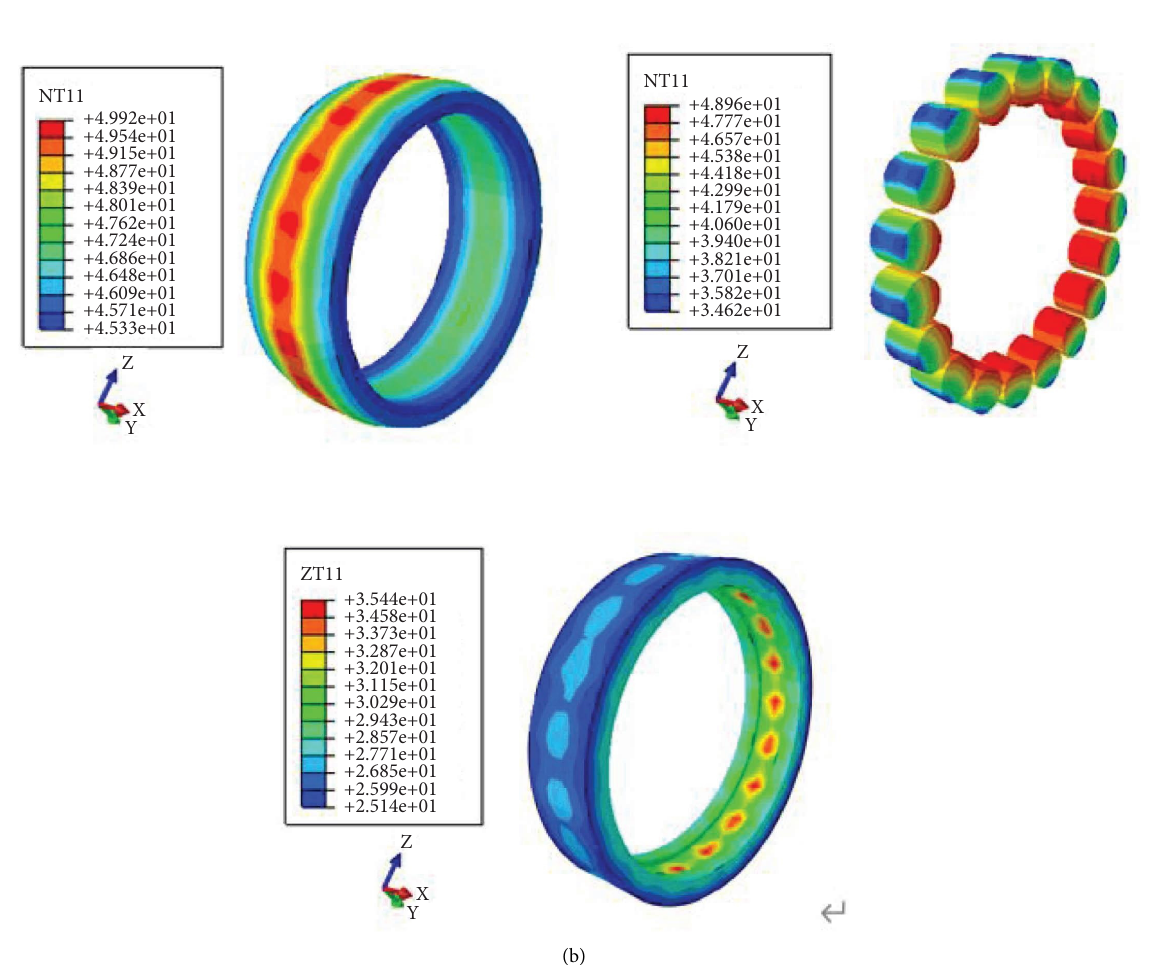
Figure 9: Bearing steady-state temperature distribution: (a) considering the heat of tractor motor and rotor and (b) without considering the heat of tractor motor and